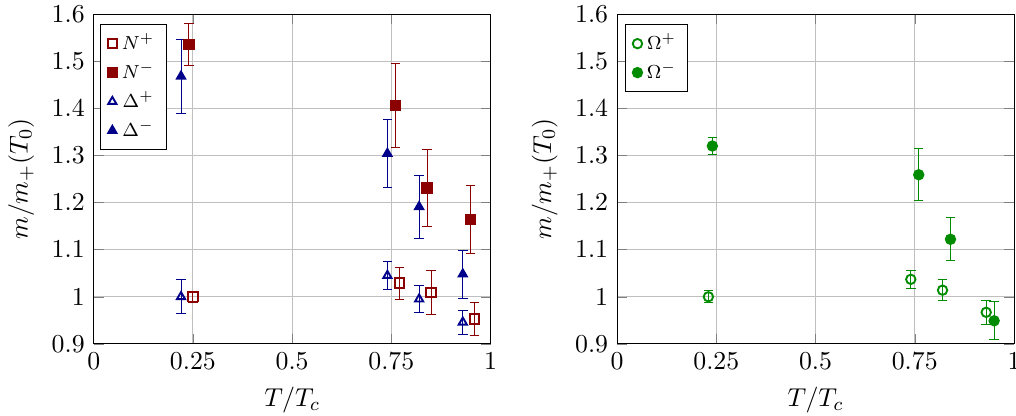
. The di(cid:11)erence (cid:14)m N; (cid:1) ; (cid:10) (cid:0)